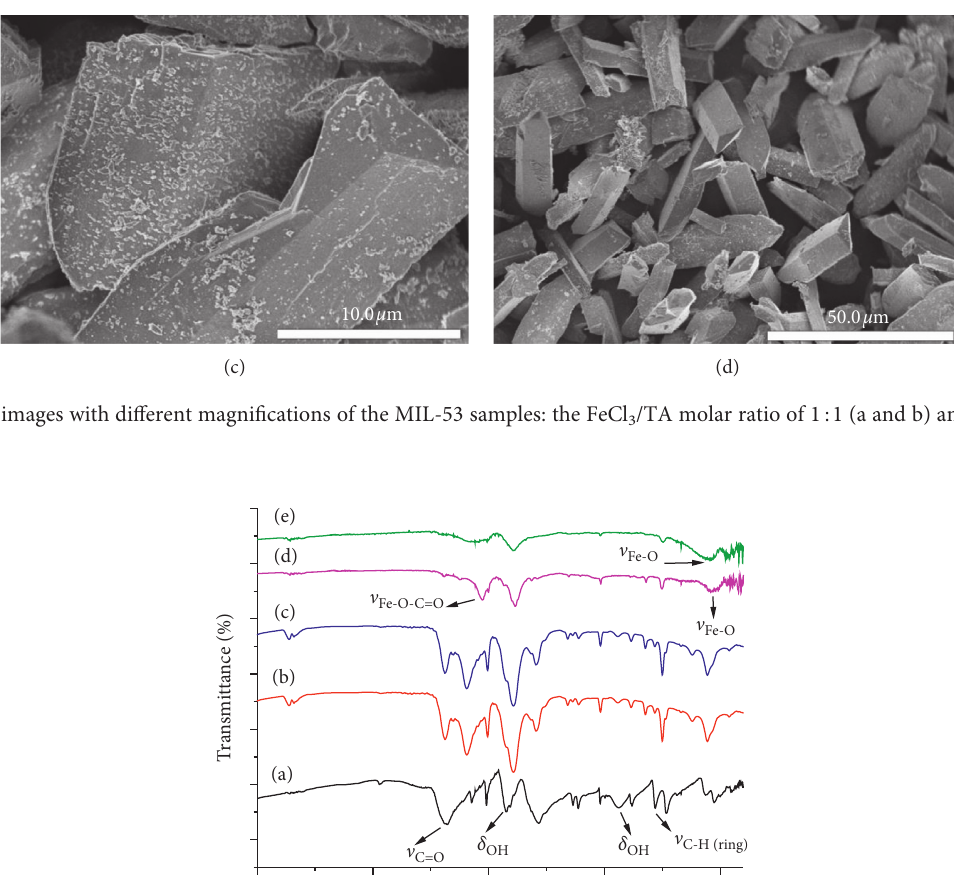
Figure 3: FT-IR spectrum of terephthalic acid (a); FT-IR spectra of MIL-53 samples synthesized at the temperature of 100 ° C (b), 120 ° C (c), 150 ° C (d), and 180 ° C (e) (FeCl 3 : TA molar ratio of 1 :2).